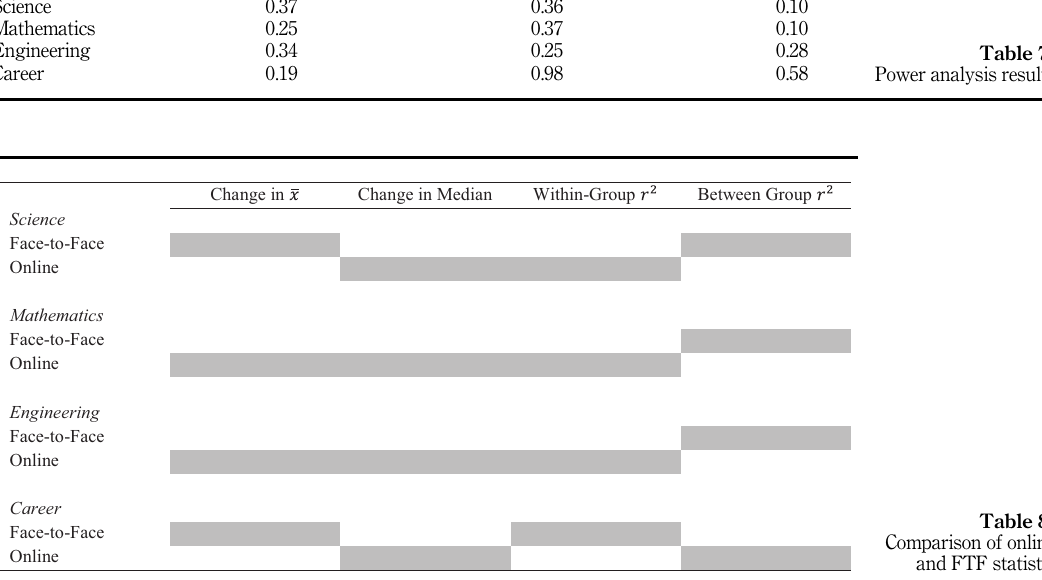
Table 8. Comparison of online